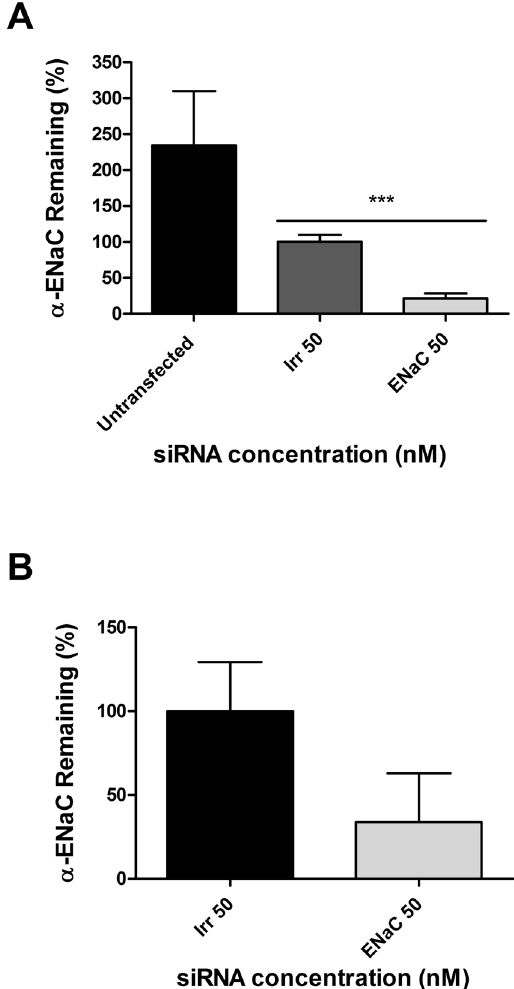
Figure 2. Knockdown of α -ENaC in primary cells transfected with peptide E nanoparticles. ( A ) The α -ENaC expression in NHBE submerged cultures (n = 5) treated with 50 nM siRNA was 21.5% relative to GAPDH housekeeping gene. The difference was statistically significant ( *** P ≤ 0.001). ( B ) Air-liquid interface cultures of NHBE (n = 3) treated with LPRs containing 50 nM siRNA showed a remaining expression of 33.8% giving therefore a silencing of 66.2% relative to GAPDH housekeeping gene. The remaining expression of the α -ENaC gene is expressed as percentage relative to non-targeted/irrelevant siRNA-treated